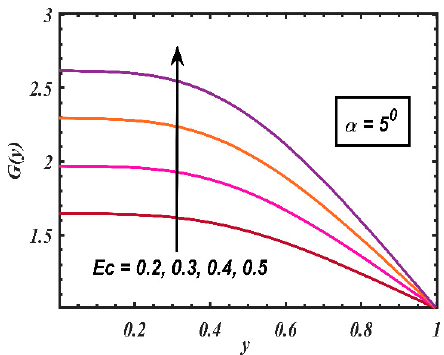
Figure 4. Variation of G(y) in diverging for Ec = 0.2, 0.3, 0.4, 0.5 and Re = 100, Pr = 5, α = 5 0 , H = 0.